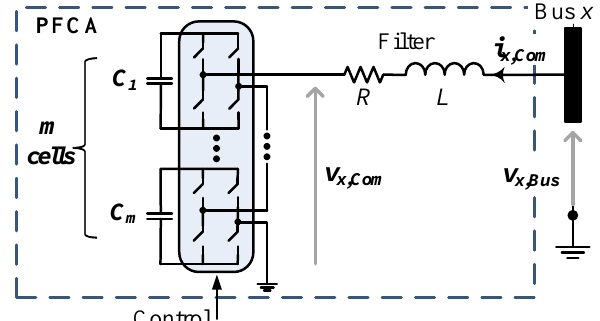
Figure 4. Representation of the PFCA implemented with cascaded single-phase H-bridge inverters, phase x.